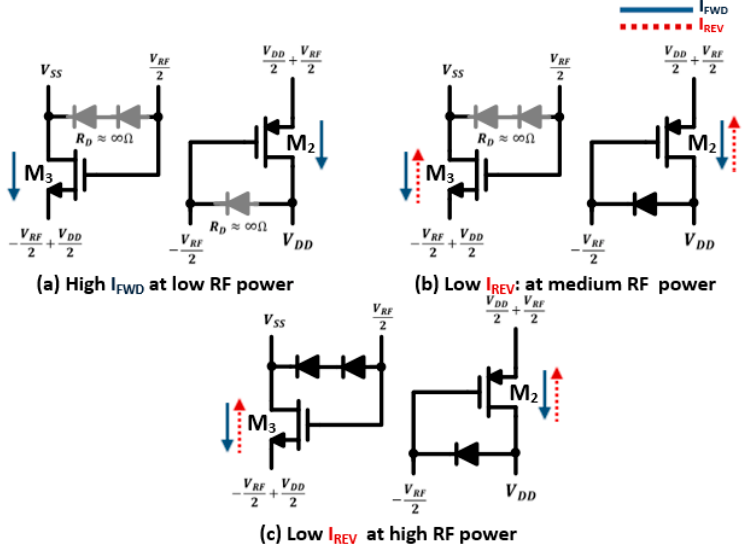
Figure 4. Steady-state operating points for NMOS and PMOS rectifying transistors during ON mode at ( a ) low; ( b ) medium; ( c ) high input RF power.